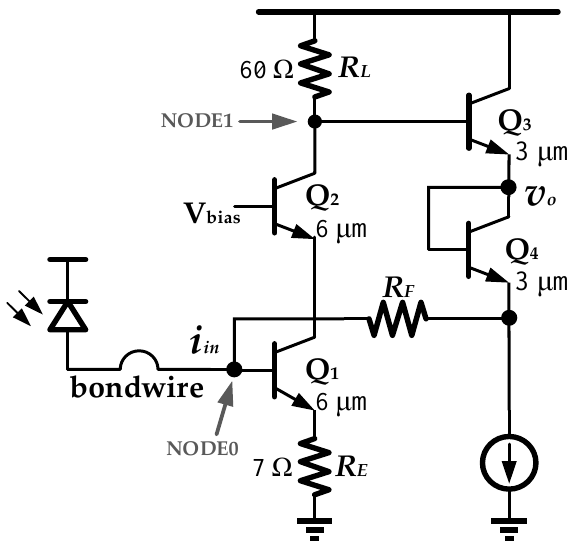
Figure 2. Schematic of the input transimpedance amplifier (TIA) stage.